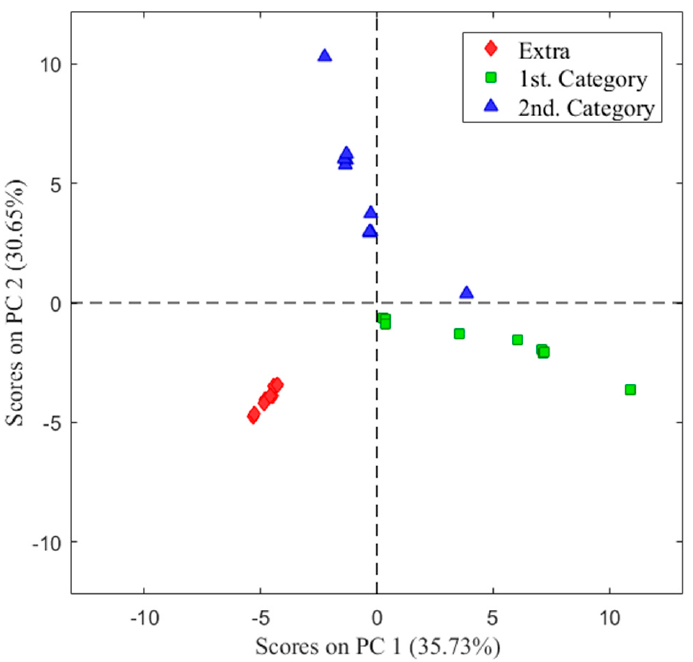
Figure 2. Score plot of the principal component analysis (PCA) analysis for healthy (extra) and defective olives (1st and 2nd categories).